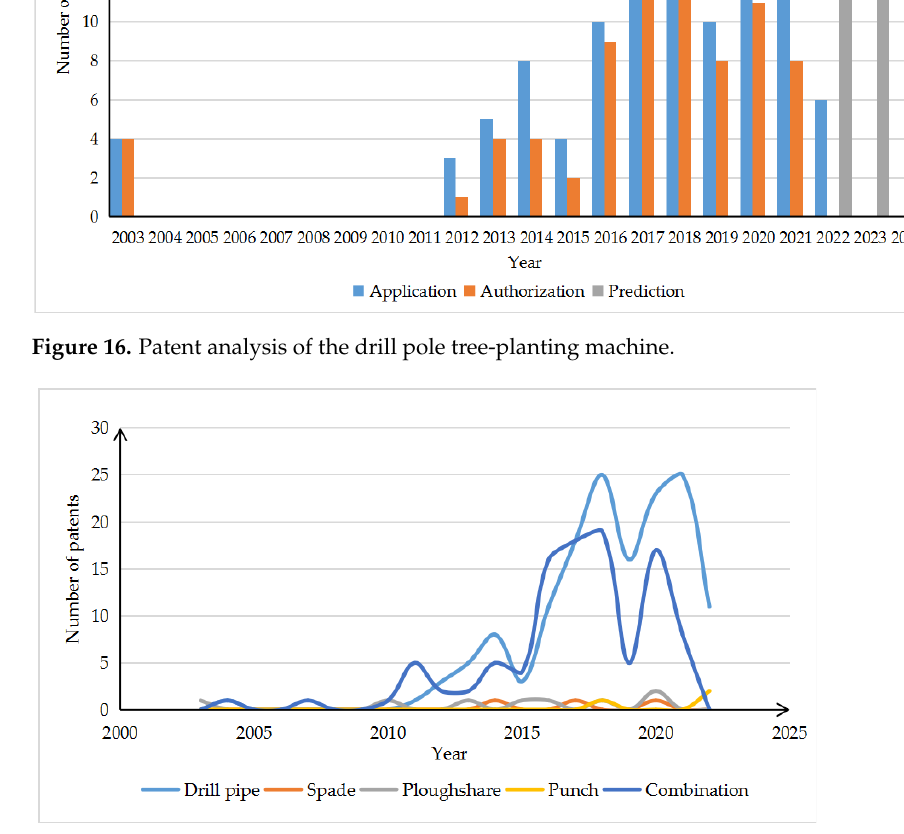
Figure 17. Comparative analysis of tree-planting technology.